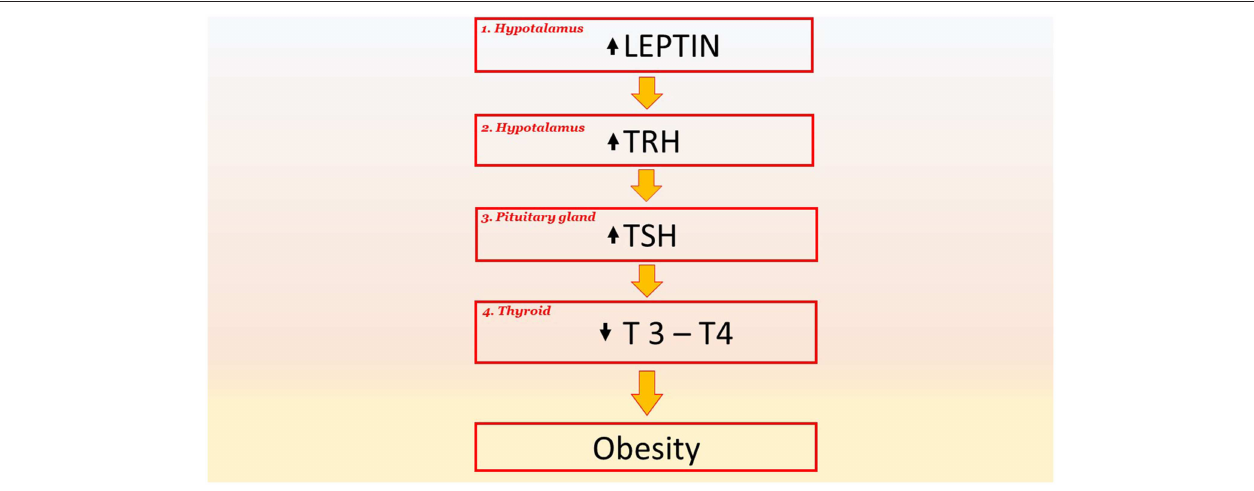
FIGURE 3 | The key role of TSH signaling and their downstream effectors in pathological phenomena and obesity. Leptin stimulates the production of TRH in the hypothalamus (point 1). An increase in TRH induces an increase in TSH in the pituitary gland (point 2); this increase results in a decrease in the hormones T3 and T4 in the thyroid (point 3). The reduced production of T3 and T4 reduces the basal metabolism by 40% and this favors obesity. TRH, Thyrotropin-releasing hormone; TSH, Thyroid-stimulating hormone; T4, thyroxine; T3, triiodothyronine.